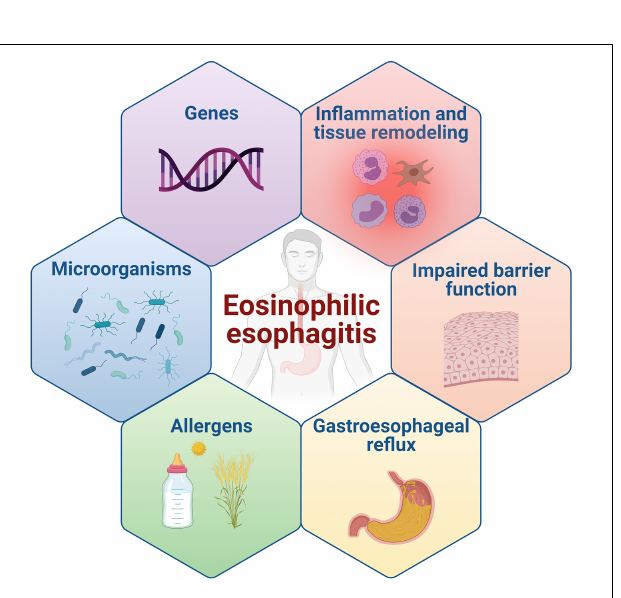
(Blanchard et al., 2010). EDC genes include FLG,